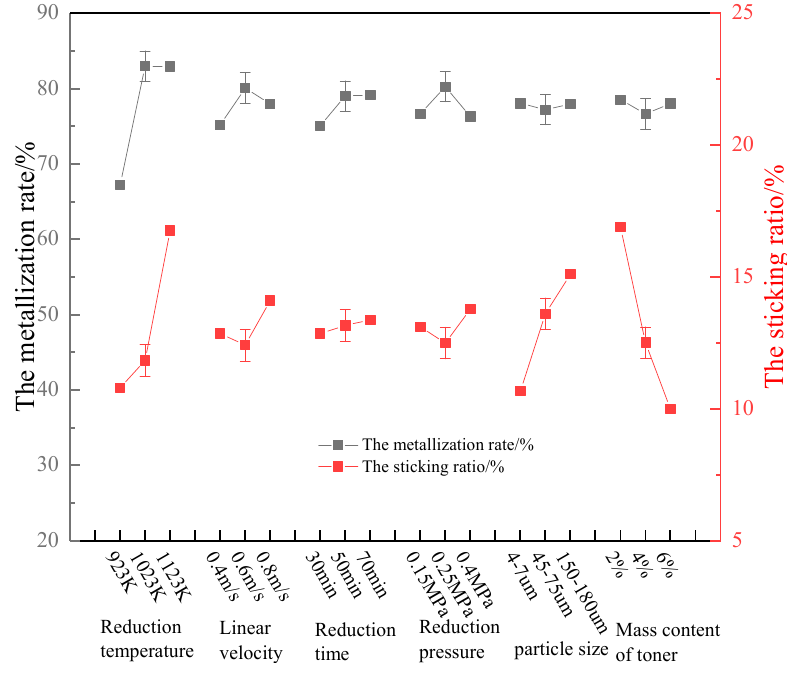
Figure 3. Relationship between metallization rate and adhesion ratio at different factor levels.